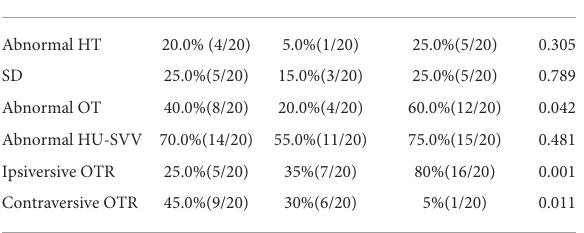
TABLE 1 Prevalence of the components of OTR in three groups patients.